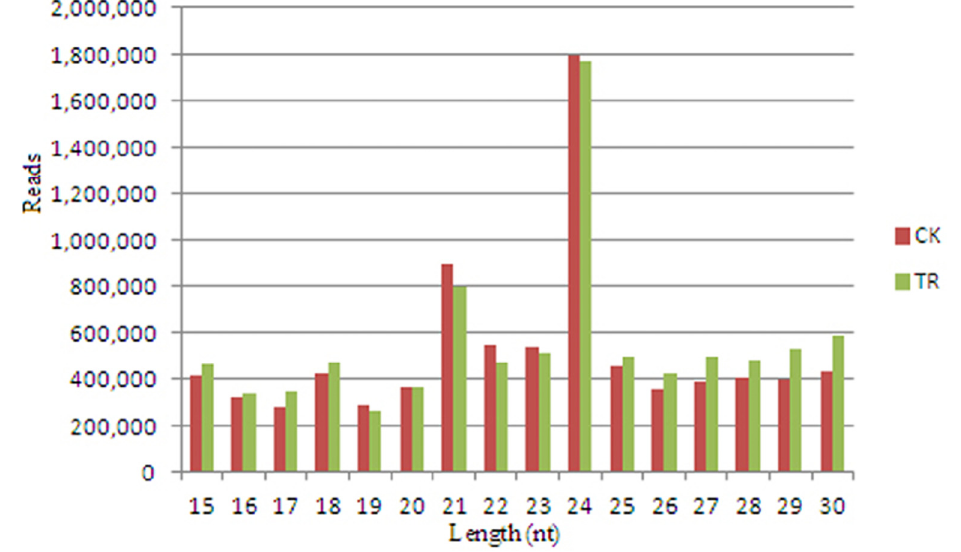
Figure 1. Length distribution of mappable small RNAs in two databases of S. linnaeanum roots. TR represents library of NaCl treatment, and CK represents library of control.